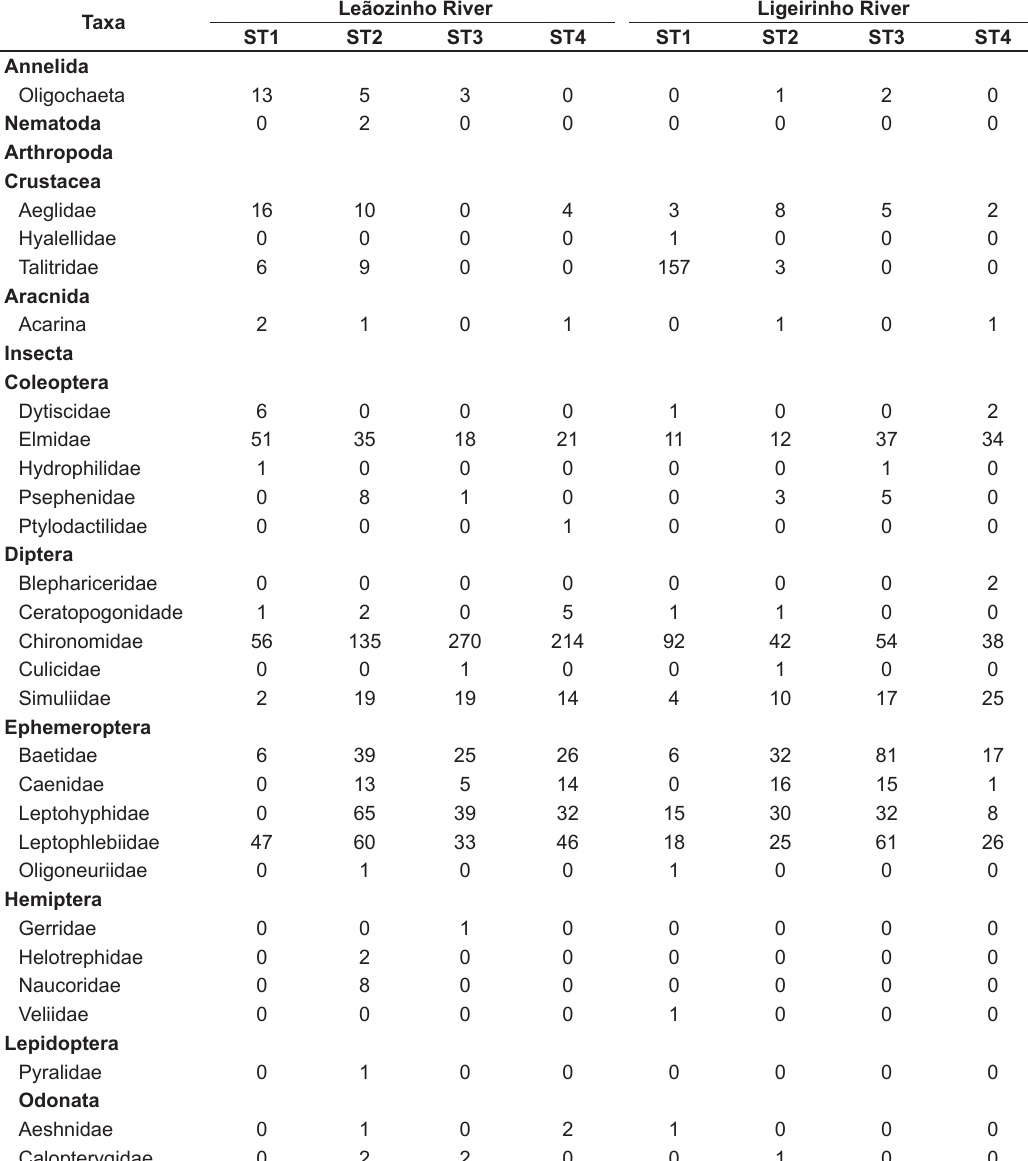
Table 1. Total number of benthic macroinvertebrates collected in the Leãozinho and Ligeirinho Rivers (Erechim, Rio Grande do Sul), by site (ST1-4), from November 2014 to April